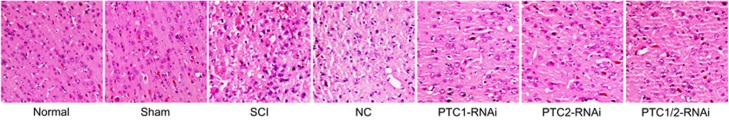
Histomorphology of HE-stained spinal tissues in the seven groups. Notes: Gli-1, glioma-associated oncogene homolog 1; HE, hematoxylin and eosin; NC, negative control; PTC1, Patched 1; PTC2, Patched 2; SCI, spinal cord injury; Shh, sonic hedgehog.